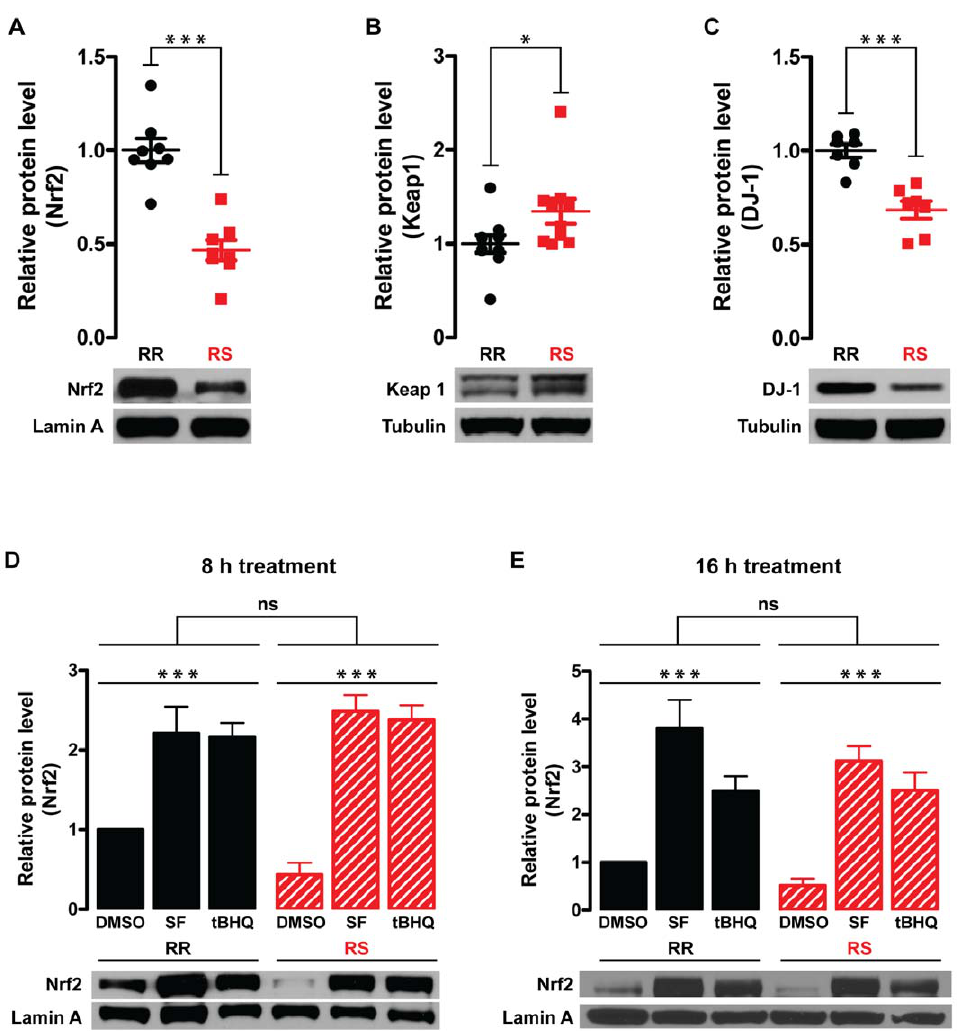
Figure 7. Differential expression of Nrf2, Keap1, and DJ-1. A . At baseline, Nrf2 protein level (apparent MW, 77 kDa) in the nuclear fraction is significantly lower in CRI-G1-RS than RR cells. B . At baseline, Keap1 protein level (apparent MW, 69 kDa) in the whole cell lysate is significantly higher in CRI-G1-RS than RR cells. C . At baseline, DJ-1 protein level (apparent MW, 21 kDa) in the whole cell lysate is significantly lower in CRI-G1-RS than RR cells. D and E . Treatment with 5 m M SF or 10 m M tBHQ for 8 h ( D ) or 16 h ( E ) activated Nrf2 pathway to a similar extent in both CRI-G1-RR and RS cells. Apparent MW for lamin A was 68 kDa; for tubulin, 51 kDa. In panels A–C, statistical significance was determined by two-tailed Student’s t-test; scatter plots of all data points are shown. In panels D and E, statistical significance was determined by two-way ANOVA; data are plotted as mean 6 S.E.M. (n=5). While there was no statistically significant difference between the two cell types overall, ad-hoc Bonferroni post-tests detected a statistically significant difference between DMSO-treated RR and RS samples (p , 0.01), similar to the difference observed with untreated samples (panel A). *, p , 0.05; ***, p , 0.001.